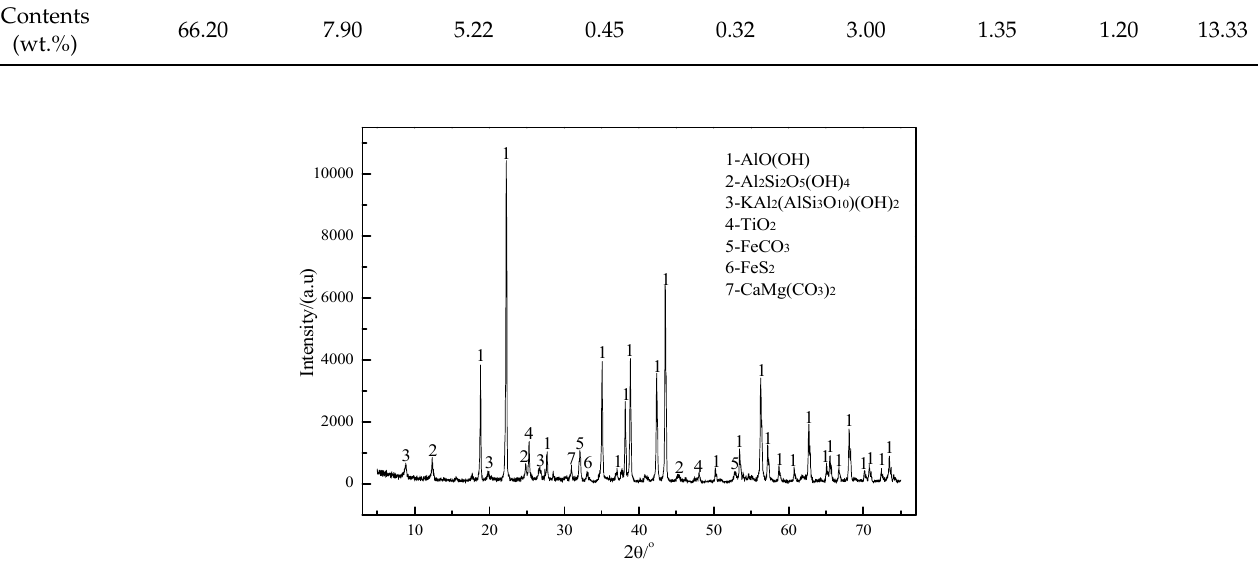
Figure 1. XRD pattern of high-sulfur bauxite. Table 2. Mineral composition of high-sulfur